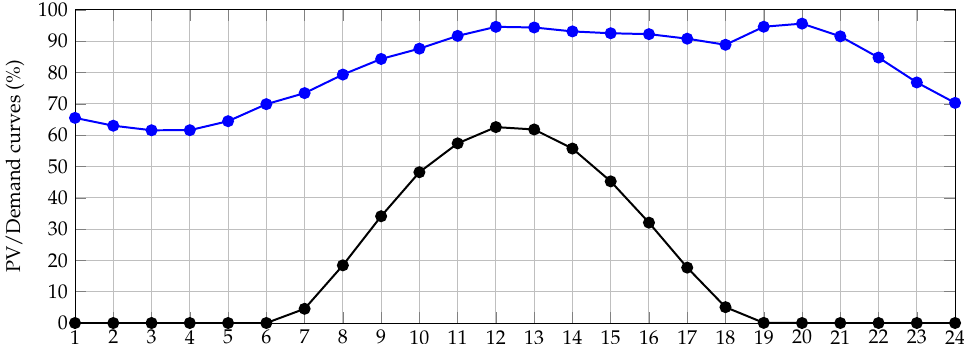
Figure 5. Graph of the electrical demand consumption and power generation with PV plants in Medellín, Colombia.